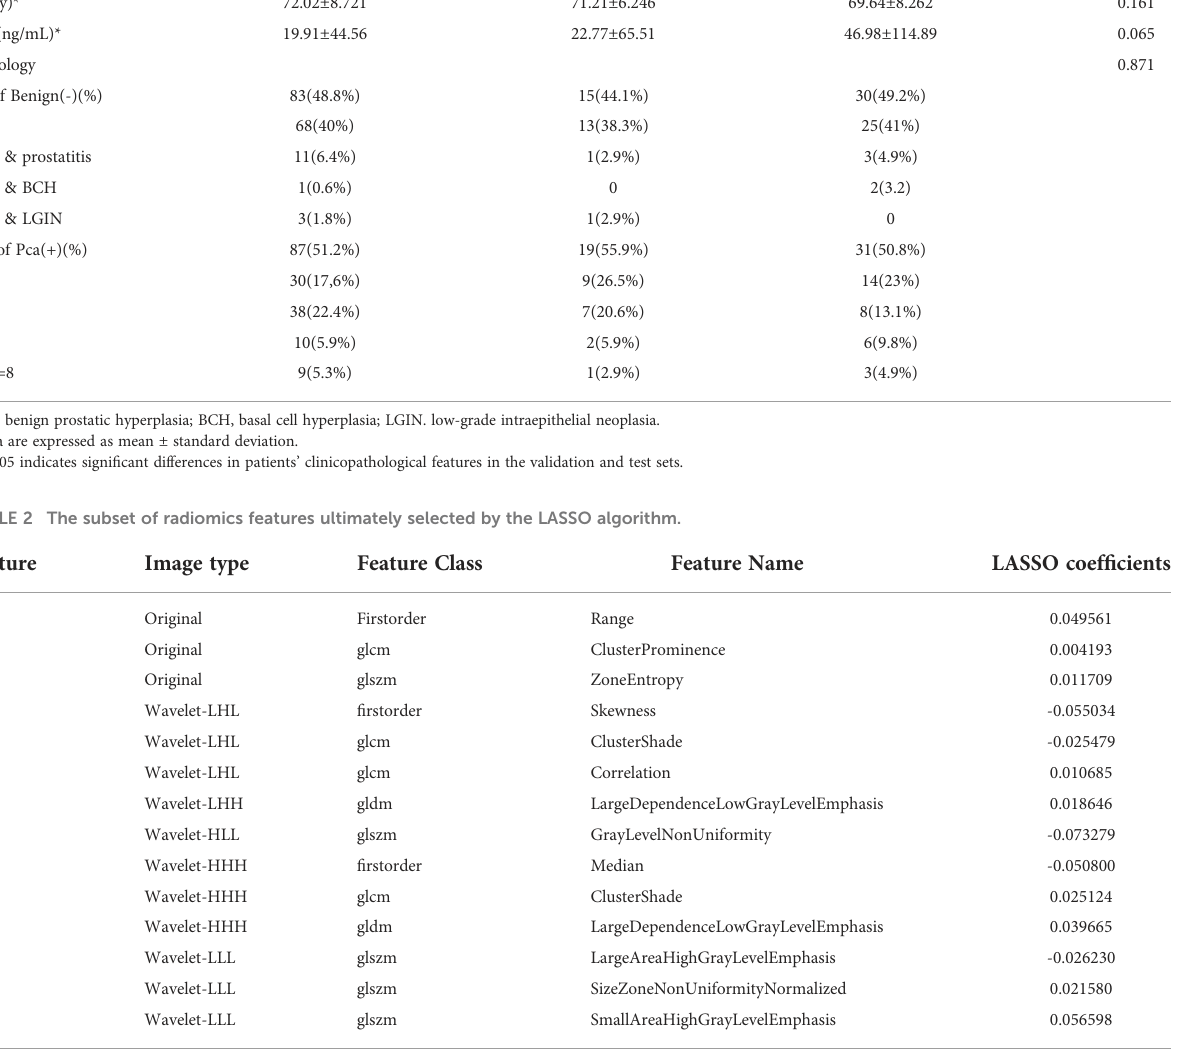
(Table 3). According to the statistical results, the SVM model was superior to radiologists ’ diagnosis based on MRI (AUC, 0.78 vs. 0.65/0.75 and 0.75 vs. 0.65/0.72) (Figure 5), and the results of the SVM model and SR were statistically signi fi cant ( p < 0.05). To evaluate the performance of ML models in CAD, we integrated the SVM model and RF model with JR and SR diagnosis through MLAD separately (SVM+RF+JR and SVM+RF+SR). The AUC, sensitivity, speci fi city, and precision of the MLAD model in the diagnosis of PCa in the validation set and the test set were as follows: (1) SVM+RF+JR: 0.8, 74% (95%CI: 0.49 – 0.90), 87%